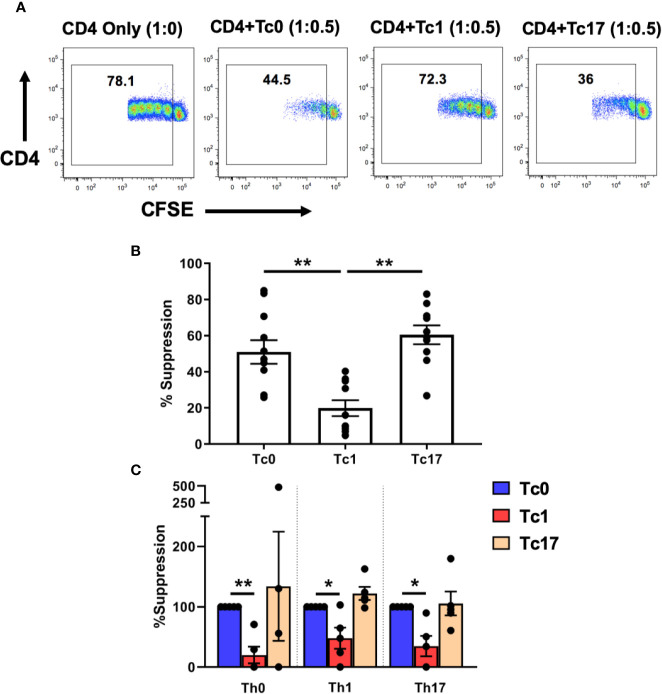
Tc lineages differ in their functional ability to suppress CD4+ immune responses. Cells obtained from Tc0, Tc1, and Tc17 cultures were assessed for suppressor ability against autologous CFSE-stained, ex vivo-sorted bulk CD4+ CD25- T-cells (A, B). Panel (A) shows representative flow cytometric plots demonstrating proliferation of CD4+ T-cells in the presence or absence of indicated Tc cells. Numbers indicate the proportion of cells within the proliferating fraction on day 7 of suppression assay. % suppression was calculated from the proliferation data. Panel (B) shows cumulative suppression data, indicating significantly decreased suppression by Tc1 cells (n = 10 independent samples). In Panel (C)
ex vivo-sorted naïve CD4+ T-cells were first differentiated along Th0, Th1, and Th17 lineages for 7 days and then stained with CFSE and subjected to suppression assays using autologous differentiated Tc0, Tc1 and Tc17 cells (n = 5 independent samples). For all three Th types, suppression was normalized to the Tc0 control group and in every case, Tc1 suppression was significantly reduced compared to the Tc0 control. *p < 0.05 and **p < 0.01; paired t test.